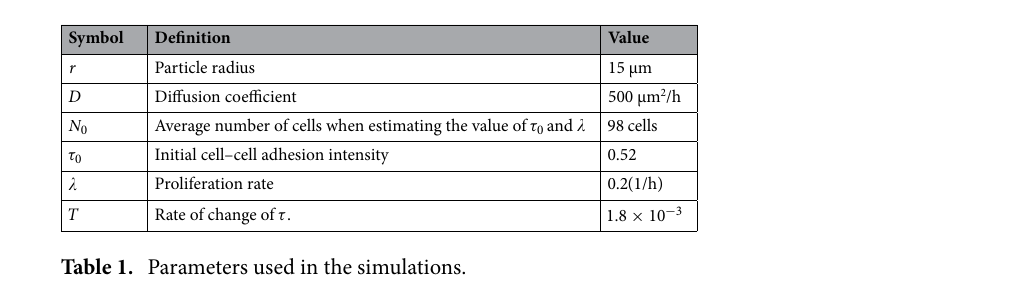
Table 1. Parameters used in the